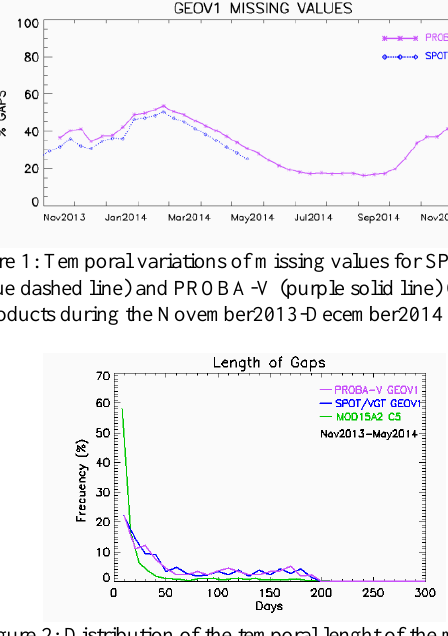
Figure 2: Distribution of the temporal lenght of the missing values over BELMANIP2.1 sites during the Nov13-May14 period for PROBA-V GEOV1, SPOT/VGT GEOV1 and MODIS C5 products.